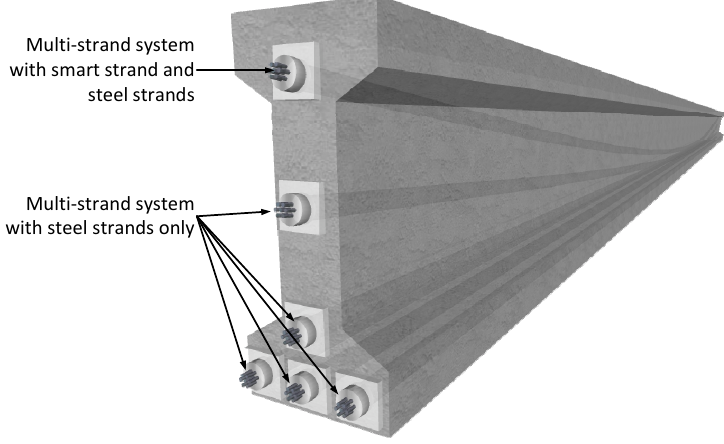
Figure 2. Prestressed concrete (PSC) girder with multiple tendons.